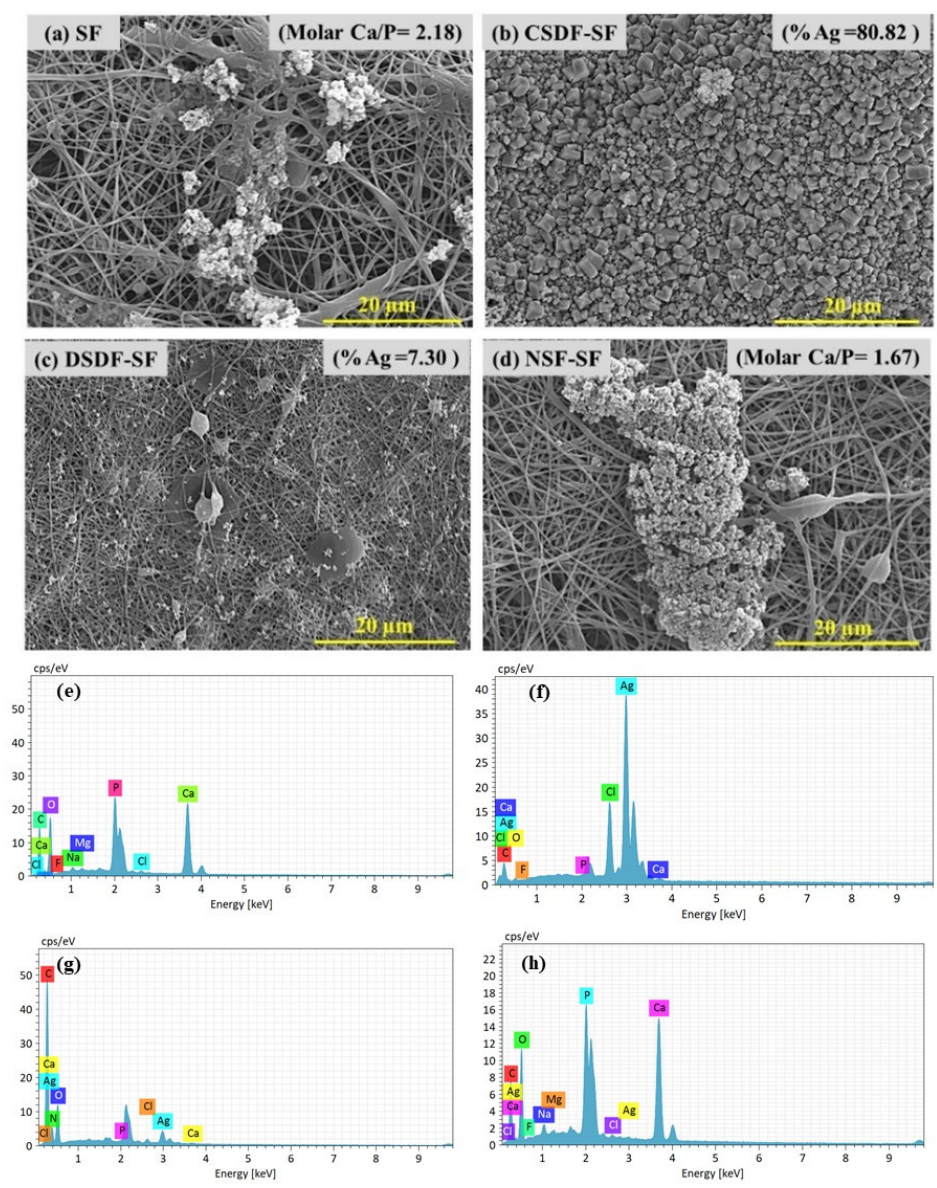
Figure 4. SEM images of biomineralized ( a ) SF, ( b ) CSDF-SF, ( c ) DSDF-SF, ( d ) NSF, and ( e – h ) their corresponding EDS spectra.